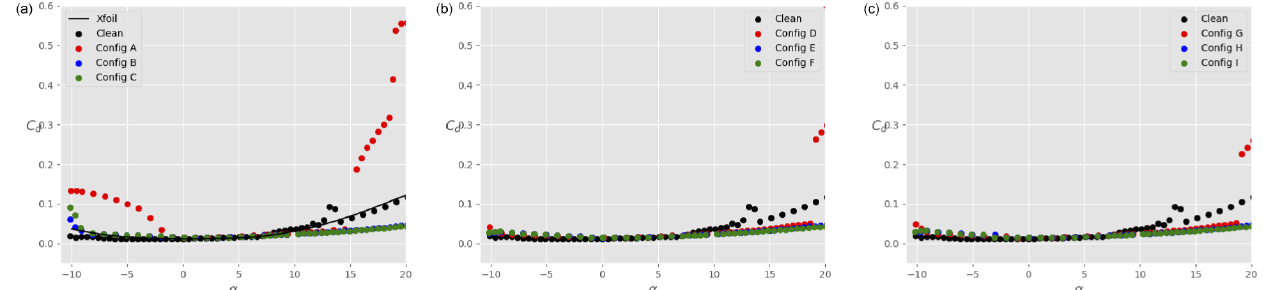
Figure 7. Total drag coefficient C d on the ensemble airfoil + slat as a function of the angle of attack α for different slat configurations, a clean main airfoil (i.e. no tripping), and Re = 1 . 5 × 10 6 : h slat /c main = 0 . 02 (a) , h slat /c main = 0 . 03 (b) , and h slat /c main = 0 . 04 (c) . The black data are taken without slat, while the coloured data are in the presence of a slat with β slat = 16 . 4 ◦ (red), β slat = 21 . 4 ◦ (blue), and β slat = 26 . 4 ◦ (green). The results of Xfoil simulations for the clean main airfoil are shown by the continuous black line in panel (a) .